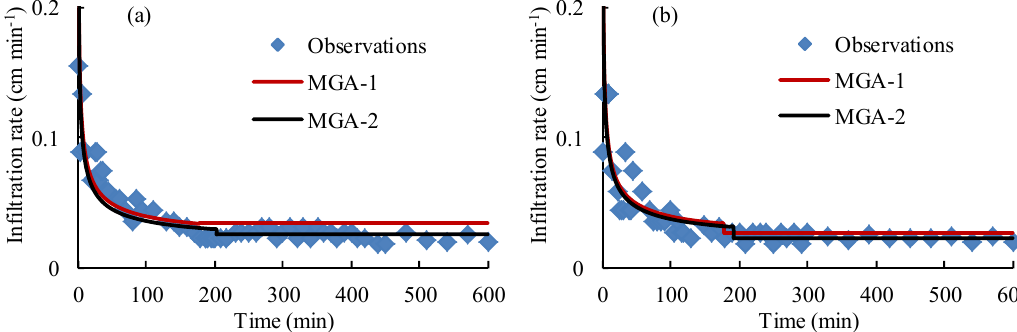
Figure 11. Comparison of the observed infiltration rate and the calculated value with the modified Green ‐ Ampt models for cases ( a ) L2SL1L2 and ( b ) L2SL2L2 in Experiment II.